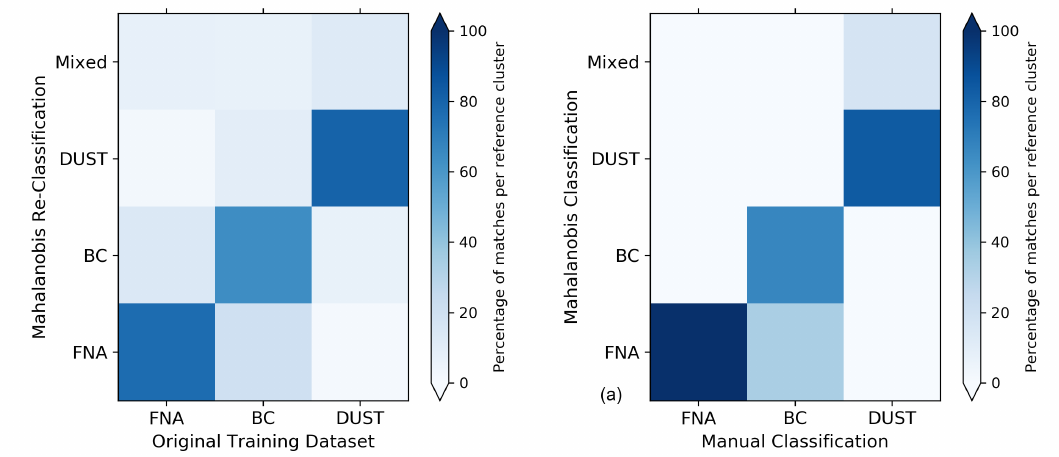
Figure 6. The Mahalanobis distance clustering technique is compared with ( a ) the clustering technique based on [6], and ( b ) the manually classified